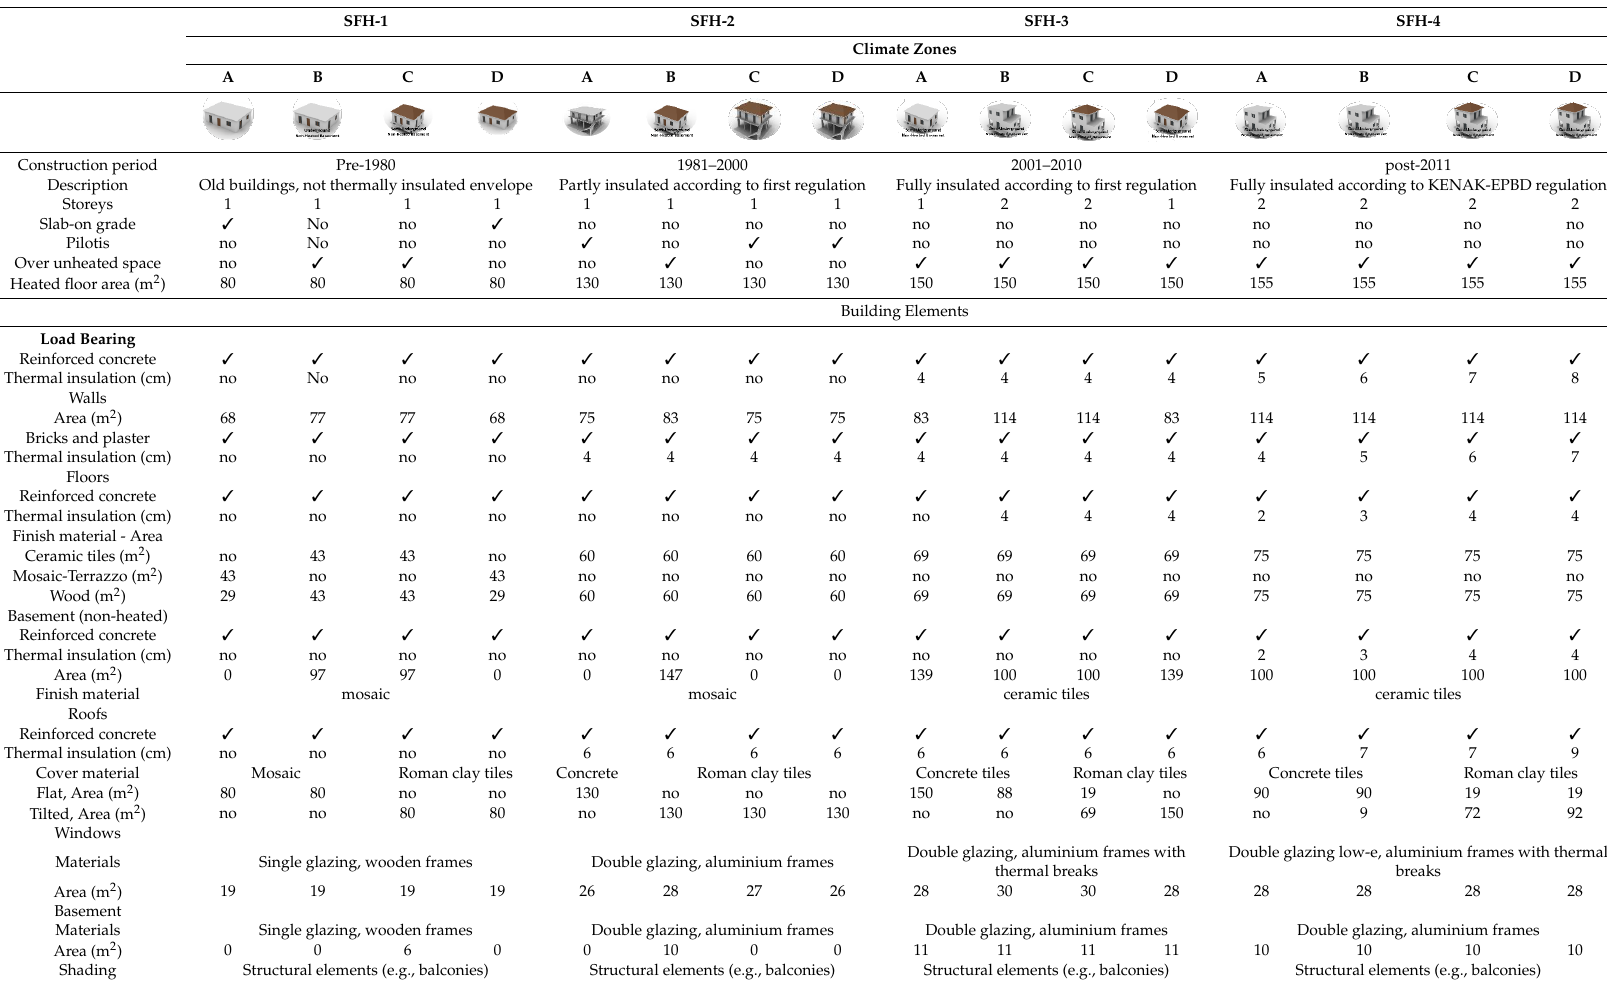
Table 1. Building and technical installation characteristics for 16 single-family houses (SFH) and other assumptions used in the calculations.